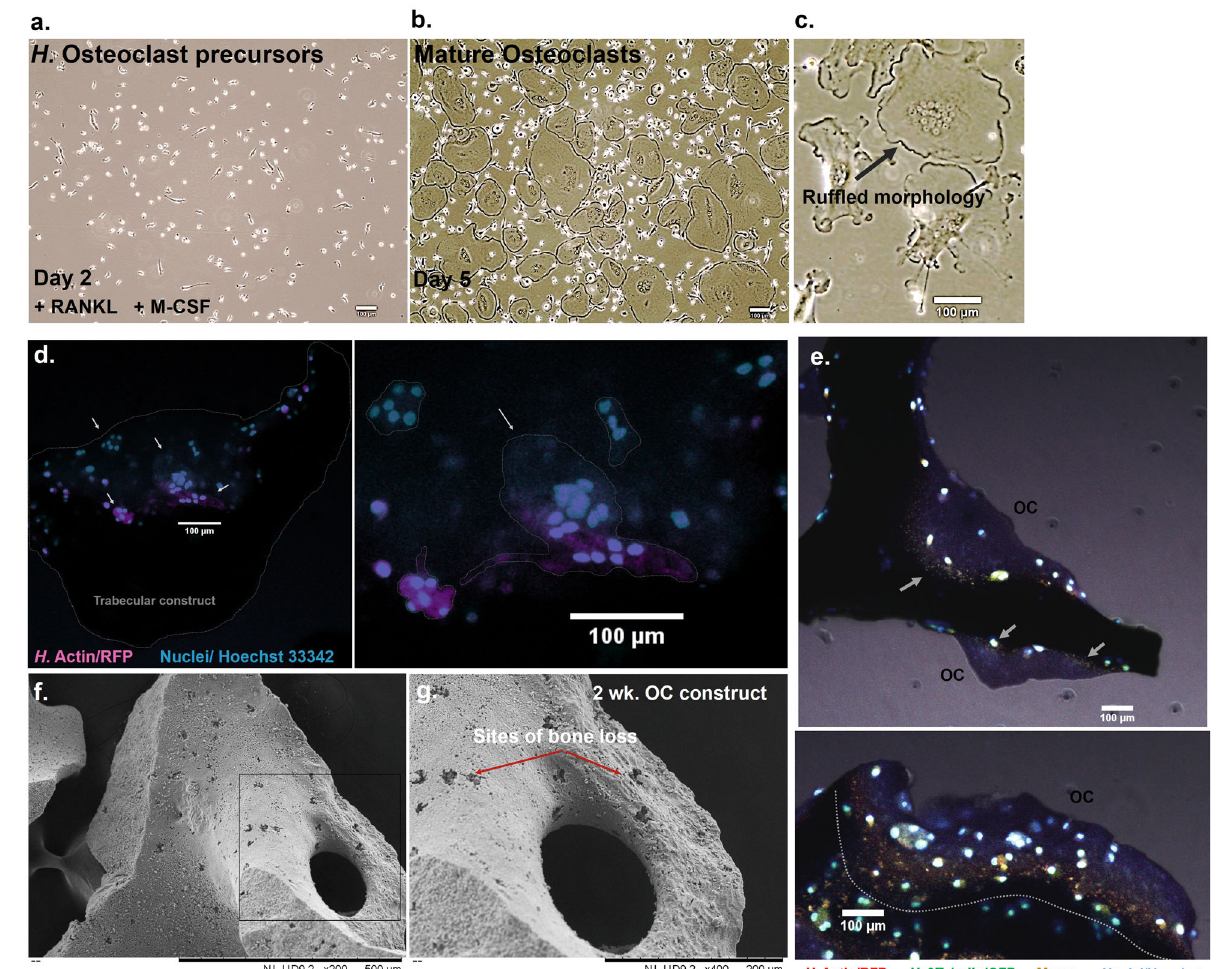
Fig. 2 Maturation of the human osteoclastic constructs and simulation of the specialised bone resorption activity encountered in vivo. Human osteoclast precursor cells of monocytic origin ( a ) are incubated in the presence of pro-osteoclastic factors RANKL and M-CSF to generate a population of multi-nucleated osteoclasts, which display the ruf fl ed morphology indicative of their active phenotype ( c , black arrow). The fusion of monocytes into polykaryons can be observed in constructs as well after 8 days of culture ( d left and zoomed, right), where they are seen agglomerating on the surface of trabeculae. Some of the formed structures are delimited (dotted lines, arrows) to allow a better visualisation. At the interface with the scaffold, these cell aggregates form belts ( e , top and bottom) that are rich in tubulin and actin (white arrows and dotted line). When cultured for 2 weeks, these cells can create perforative resorption patterns resembling pores and lacunae ( f , black box and g , red arrows). Scale bars as